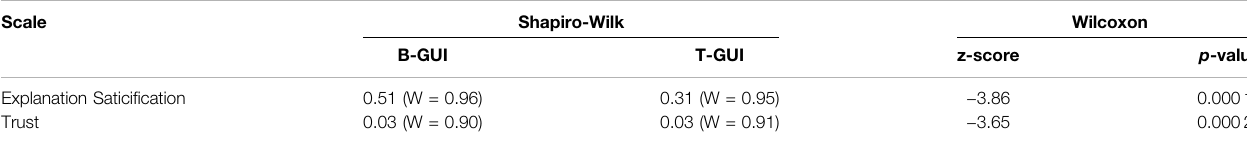
TABLE 4 | Results of statestical tests in Within-subjects design experiment ( α = 0.05), which are obtained by summation across all items of each scale.